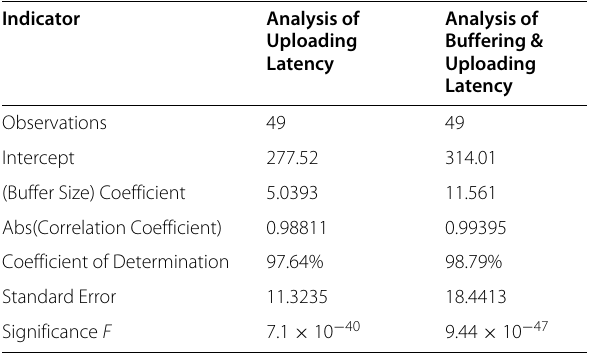
Table 4 Buffer-aided Transmission’s Regression Analysis Output Indicator